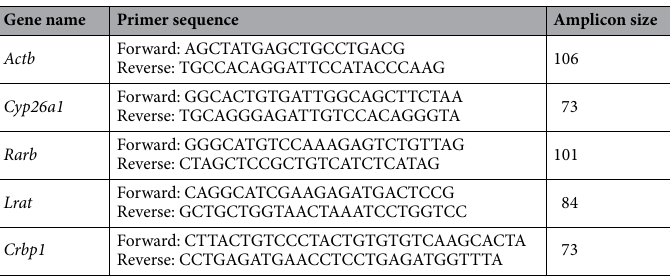
Table 3. List of genes and primers sequences used in